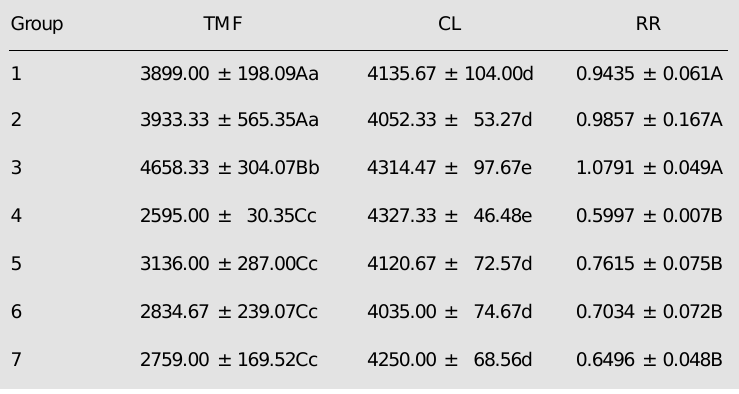
Table 1 - Total number of regenerated axons (TMF) obtained at the polyethylene tube midpoint level 4 weeks after graft transplantation. The number of myelinated fibers counted in the contralateral nerve (CL) and the regeneration rate (RR) are also presented. 1) Donor: C57BL/6J (C), recipient: F1 (C x A); 2) donor: A/J (A), recipient: F1 (C x A); 3) donor: C57BL/6J, recipient: F1 (C x B); 4)